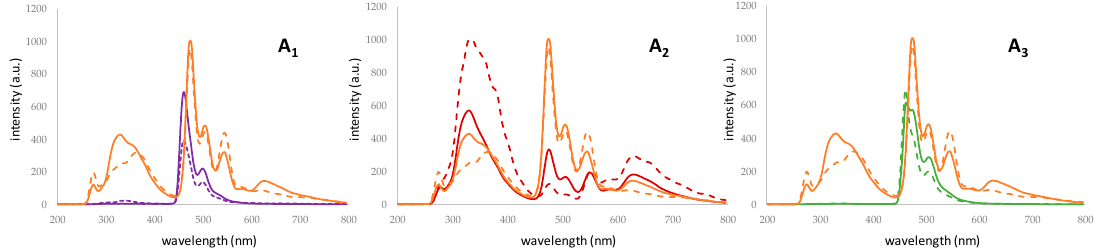
Figure 6. Fluorescence spectra of metalla-rectangles A 1 (purple), A 2 (red), A 3 (green) and L anthr (orange) at a concentration of 5 × 10 –8 M (in CH 2 Cl 2 or EtOH), under a N 2 (dotted lines) or O 2 atmosphere (solid line).